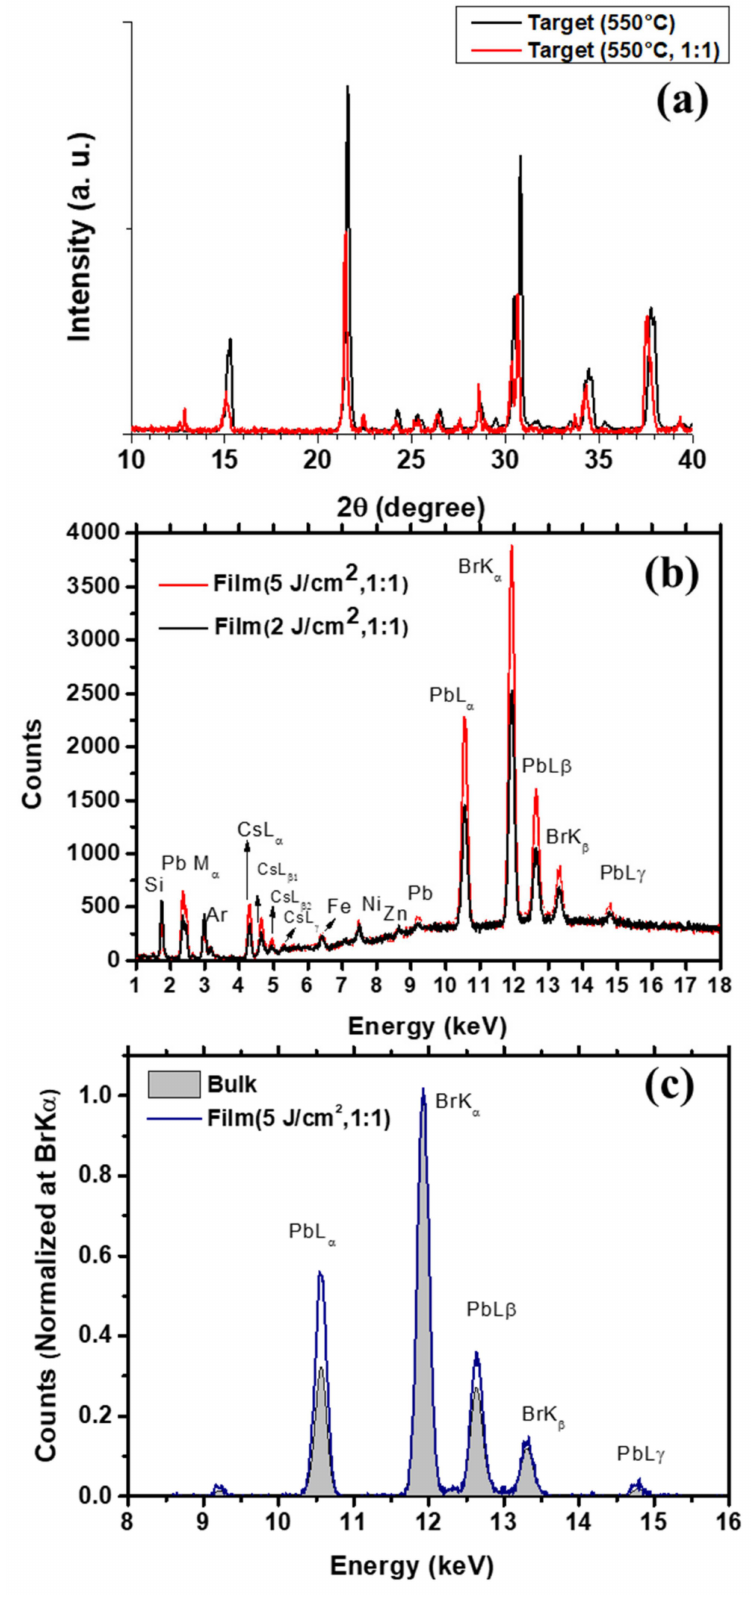
Figure 6. ( a ) XRD spectrum of Target (500 ◦ C, 1:1) compared to Target (500 ◦ C). XRF analysis. ( b ) Comparison between ( a ) Film (2 J/cm 2 , 1:1) and Film (5 J/cm 2 , 1:1), and ( c ) Film (5 J/cm 2 , 1:1) and bulk CsPbBr 3